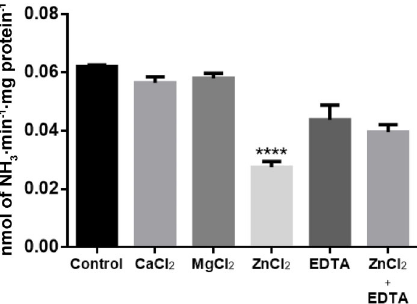
Figure 4. Effect of ions on adenosine deaminase (ADA) activity in human lymphocyte-rich peripheral blood mononuclear cells (n=4). The fi nal concentration of CaCl 2 , MgCl 2 , ZnCl 2 , and EDTA was 5.0 mM. Control: without ions or EDTA. The data are reported as means ± SE for n=4. ****P o 0.001 compared to control group (ANOVA followed by Tukey